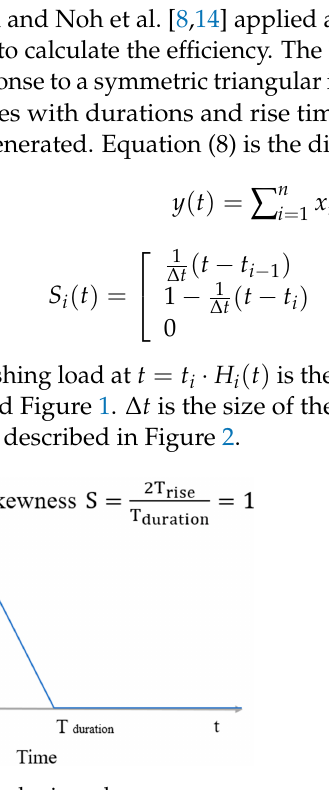
Figure 1. Unit triangular impulse.